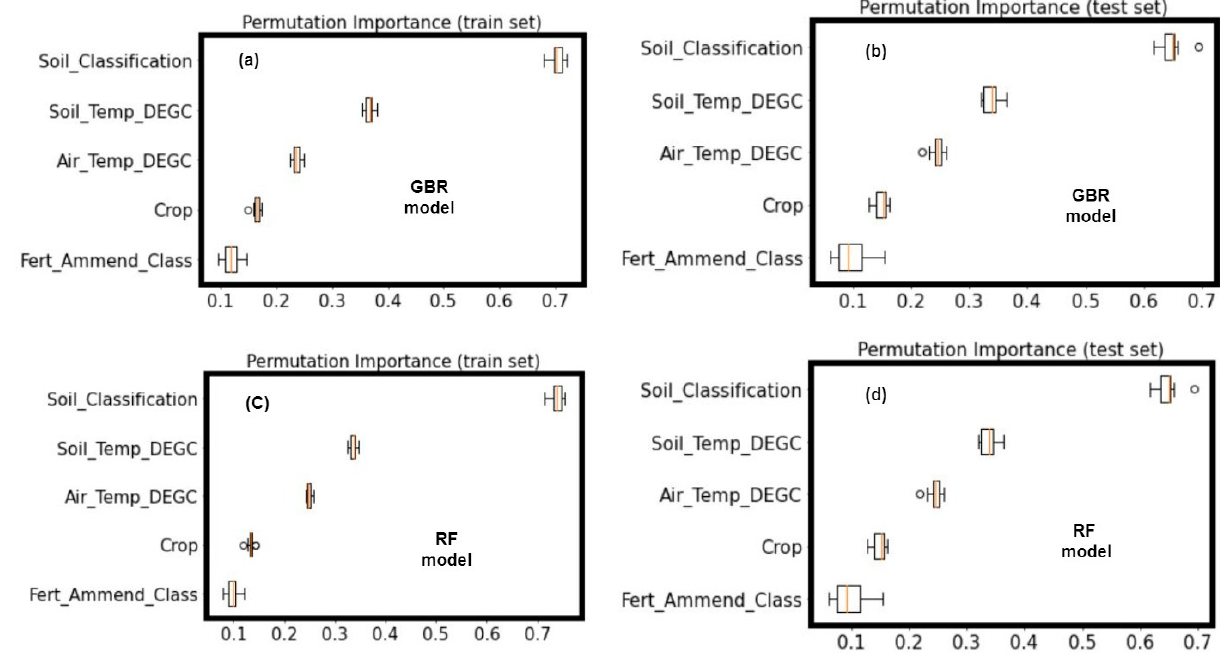
Figure 4. Permutation feature importance (PFI) of the five predictors: ( a ) shows the PFI on the training dataset of the GB regression model; ( b ) shows the PFI on the test dataset of the GB regression model; ( c ) shows the PFI on the training dataset of the RF model; and ( d ) shows the permutation importance on the test dataset of the RF model. Soil_Classification, soil classification; Soil_temp_DEGC, soil temperature (°C); Air_Temp_DEGC, air temperature (°C); Crop, cropping system; Fert_Ammend_Class, type of fertilizer amended to the crops.